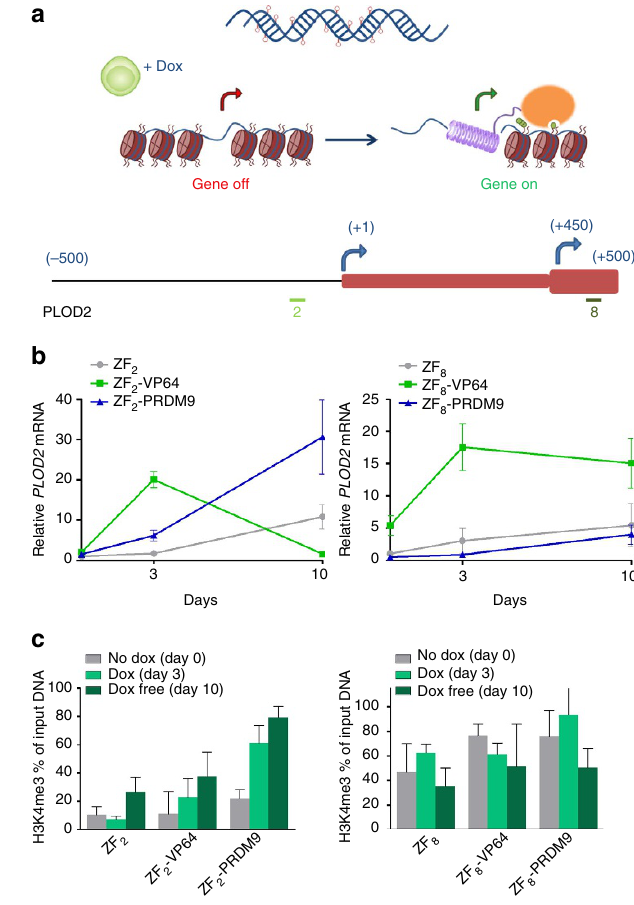
Figure 4 | Stability and maintenance of gene reactivation after induction of H3K4me3 in the repressed non-methylated PLOD2 gene in C33a cells. ( a ) Schematic representation of the stable doxycycline inducible system and the two regions targeted by the ZF protein fusions. ( b ) Relative PLOD2 messenger RNA (mRNA) expression, at each specific time point using two different ZFs targeting the promoter region. ( c ) H3K4me3 ChIP–qPCR enrichment at the promoter region of PLOD2 at each specific time point. n ¼ 3 independent experiments; error bars ±